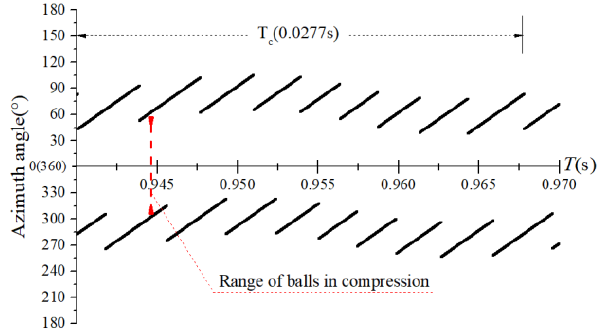
f = 1.2 N). Figure 23. Time-domain diagram of the load region ( f ce = 1.2 f = 1.2 N). ce ce f = 1.2 N). ce